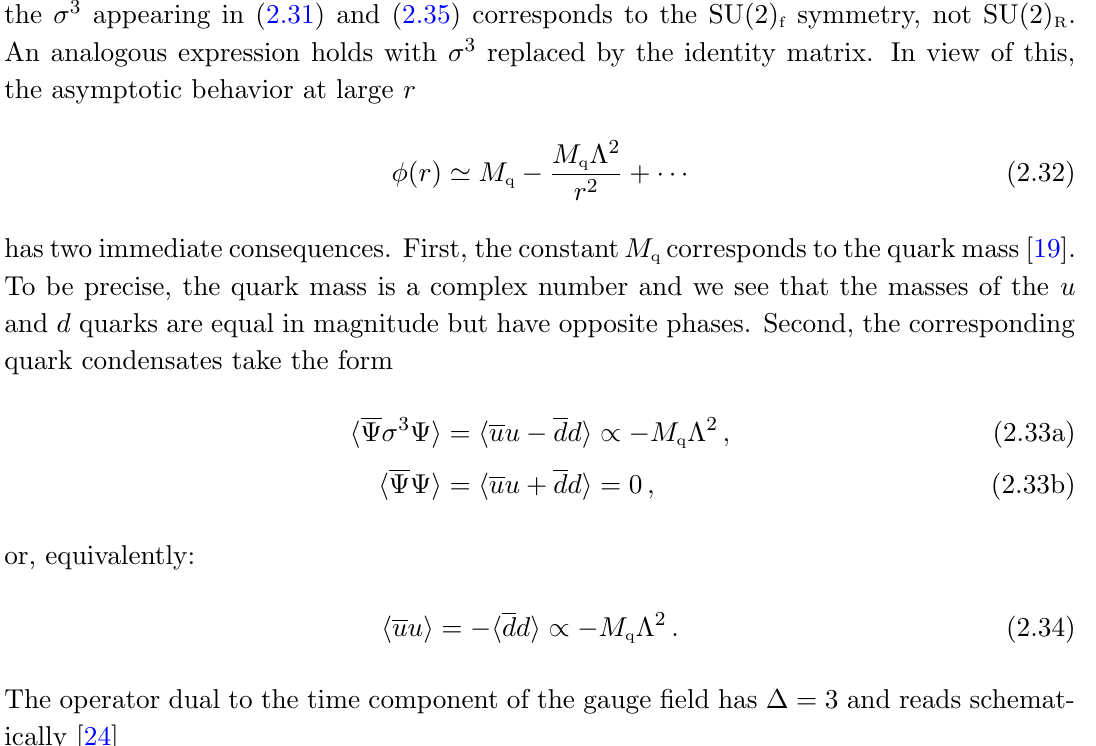
Figure 1. Embedding pro(cid:12)le of the D7-branes in the z 1 -direction for (cid:3) = M and (cid:3) = M = 10 (continuous, blue curve). We have extended the range of the radial coordinate to q negative values to represent a section of the solid of revolution in the y i